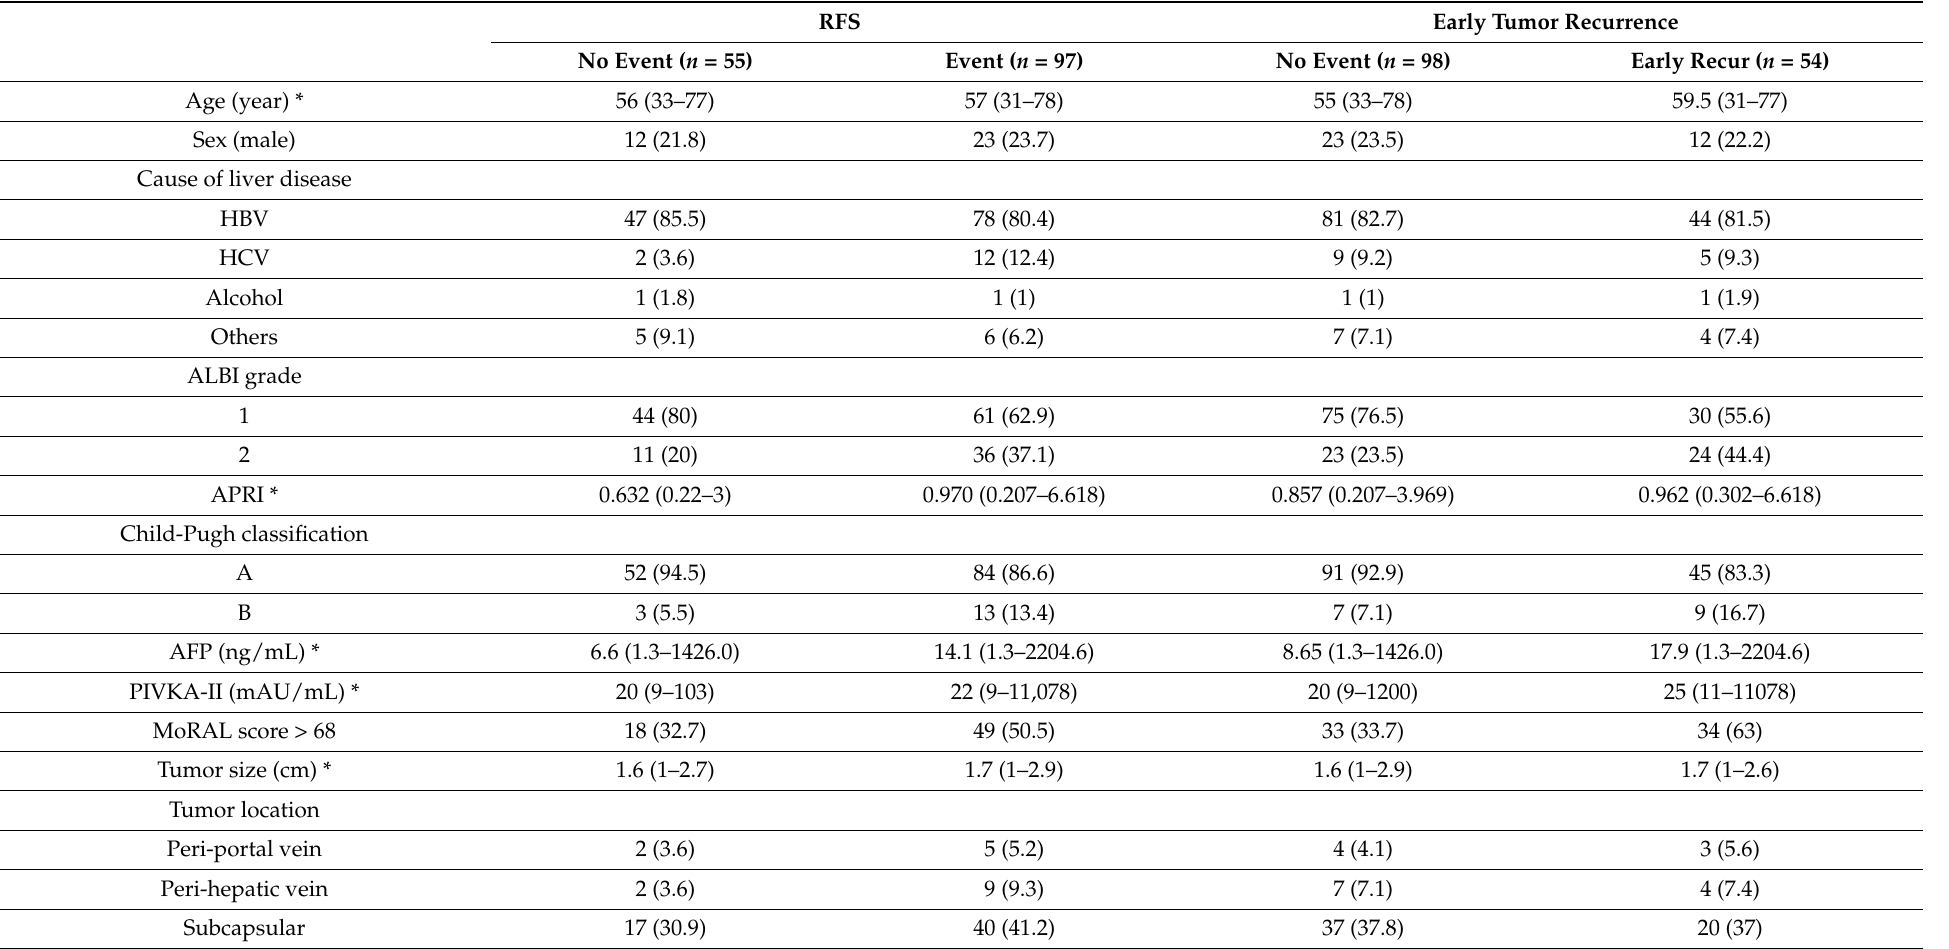
Table 1. Patient